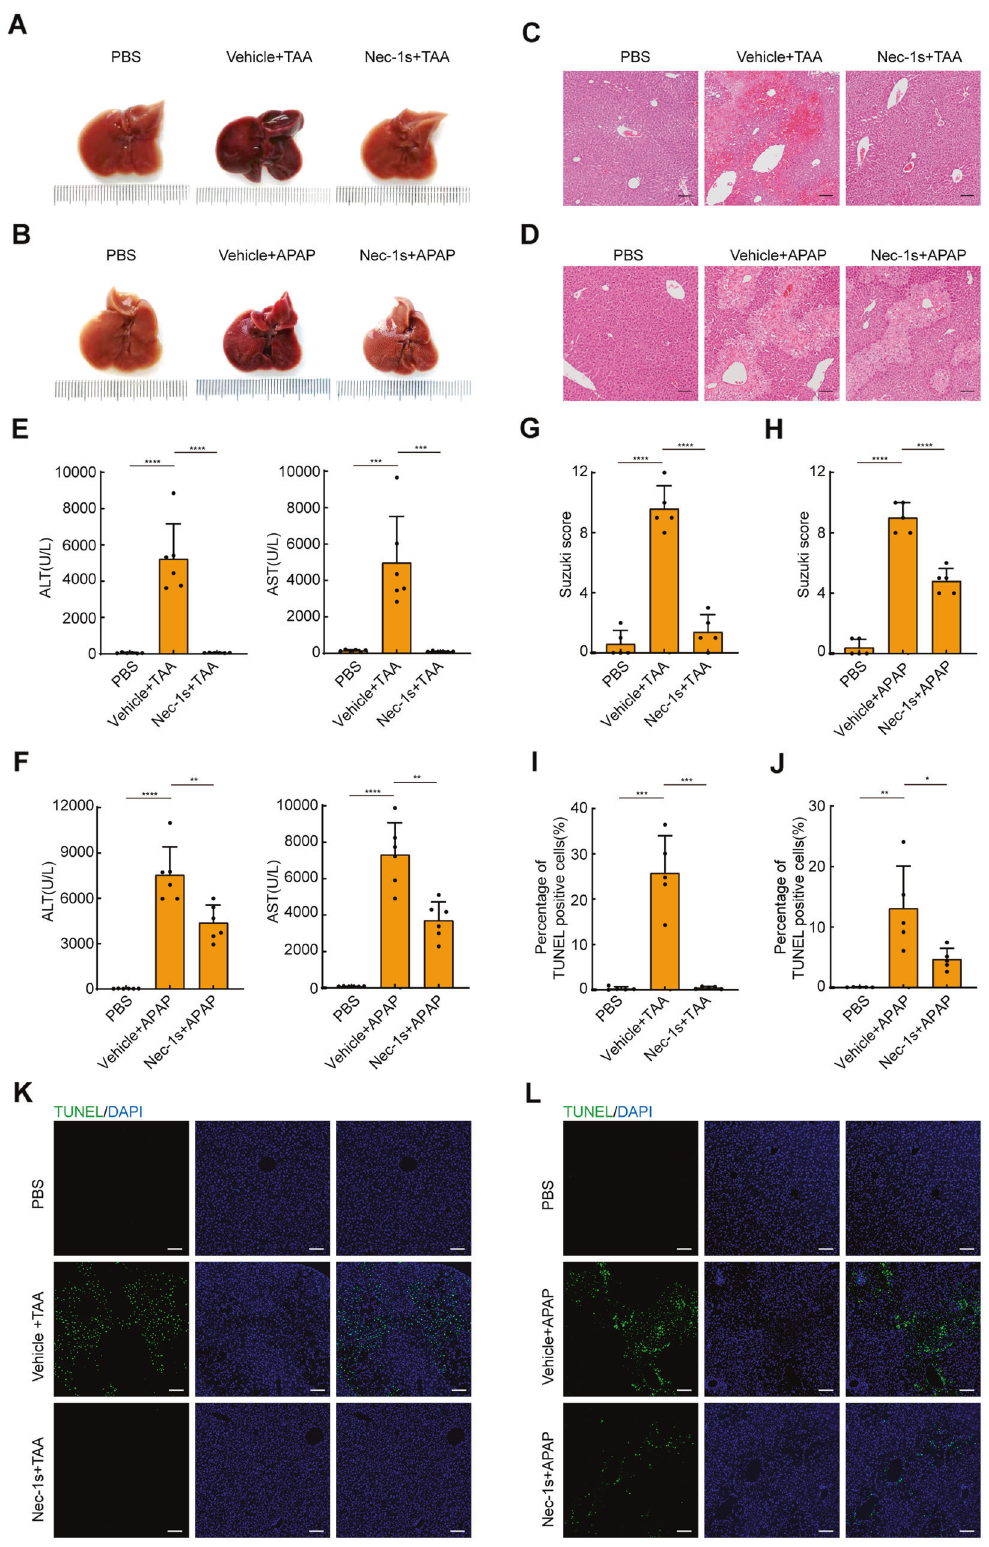
Fig. 4 Nec-1s protects mice against ALF induced by TAA or APAP. A , B Representative macroscopic appearance of livers at 24 h following TAA or APAP treatment in the presence or absence of Nec-1s. C , D Representative H&E-stained liver sections. Scale bars, 100 μ m. E , F Serum levels of ALT and AST(U/L) ( n = 6; mean ± s.d.). P values were determined by Student ’ s t test (** P < 0.01; *** P < 0.001; **** P < 0.0001). G , H Suzuki score of H&E-stained liver sections ( n = 5; mean ± s.d.). P values were determined by Student ’ s t test (**** P < 0.0001). I , J Percentage of TUNEL positive cells in liver sections ( n = 5; mean ± s.d.). P values were determined by Student ’ s t test (* P < 0.05; ** P < 0.01; *** P < 0.001). K , L Representative TUNEL-stained liver sections. Scale bars, 100 μ m. All experiments were repeated at least two